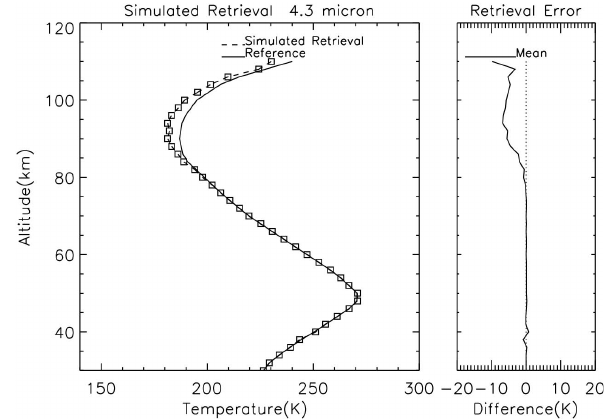
Fig. 17. Impact on the retrieved temperature profile of using the CO 2 mixing ratio error shown in Fig. 18. Right-hand panel shows the error in retrieved